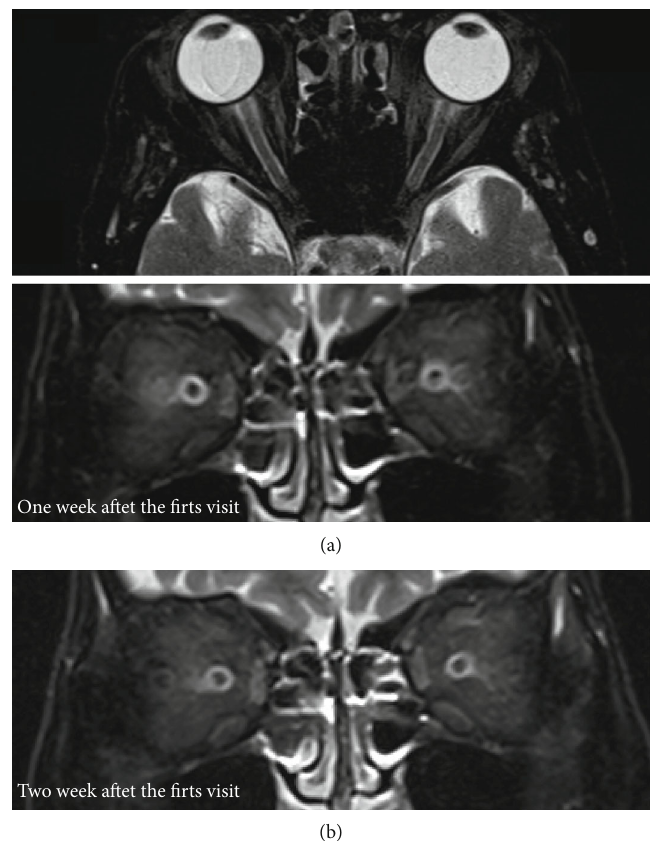
Figure 5: Magnetic resonance imaging (MRI). (a) One week after the fi rst visit, T2-weighted MRI demonstrates well-marked enhancement of the left optic nerve compared to the right optic nerve. (b) Two months after the fi rst visit, MRI showed improvement in the enhancement of the left optic nerve.